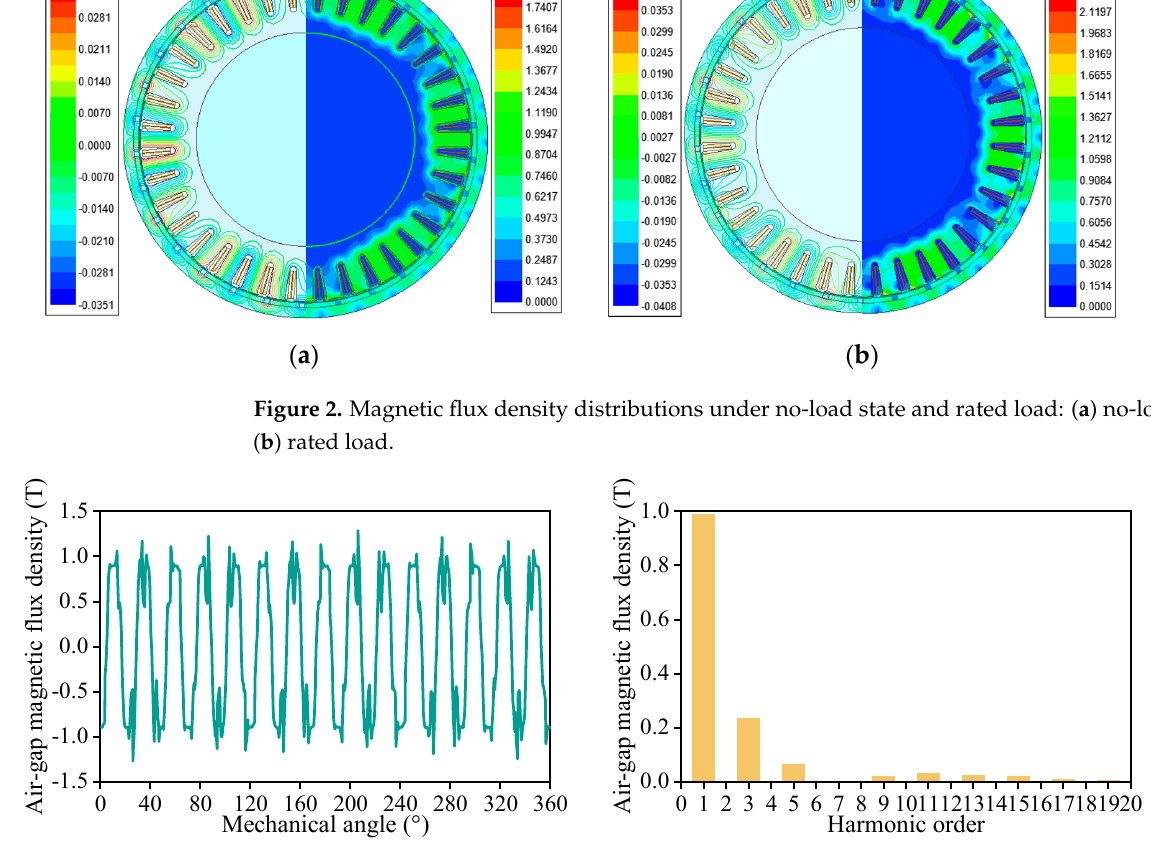
Figure 3. Radial air-gap magnetic flux density and Fourier transform results under no-load state: ( a ) radial air-gap magnetic flux density; ( b ) Fourier transform.